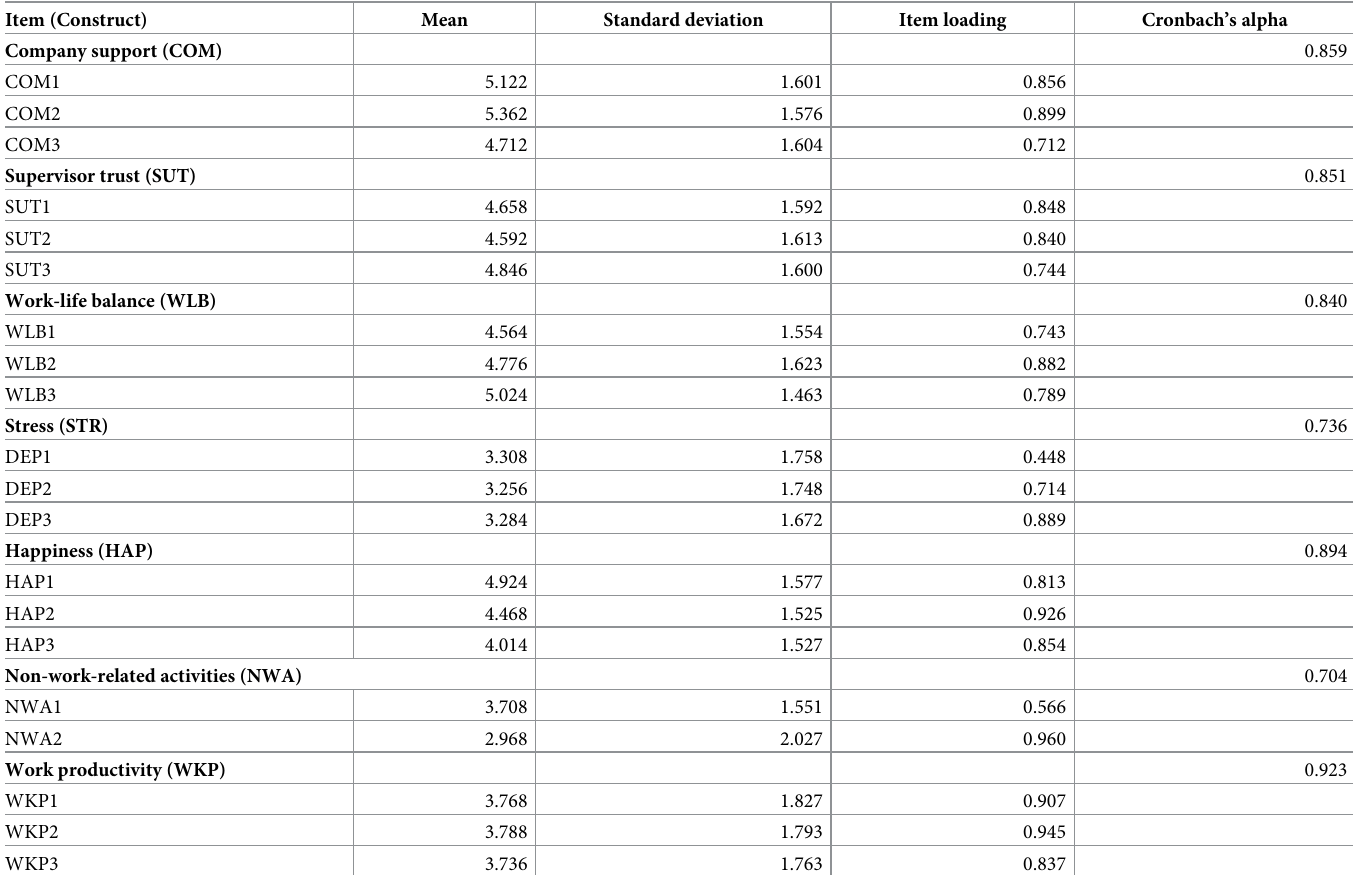
Table 2. Summary statistics of items and factor loadings.